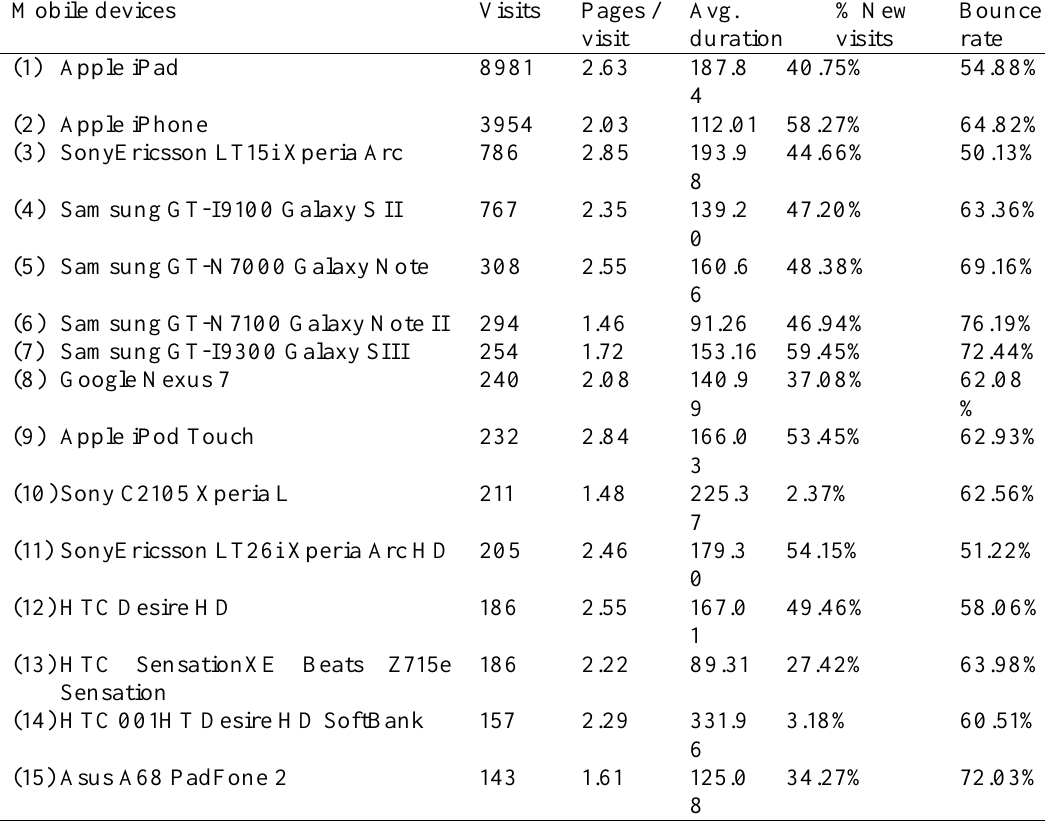
Top 15 Mobile Devices of the Visitors Mobile devices Visits Pages